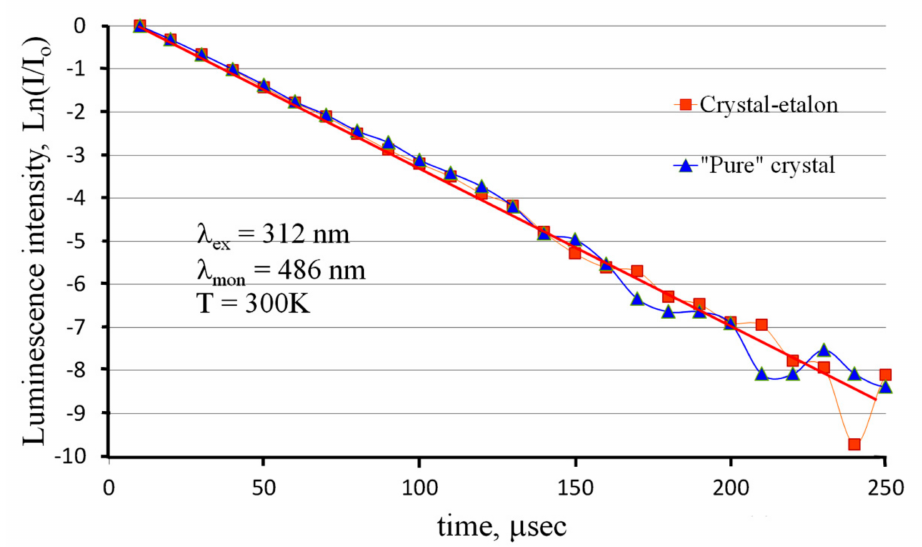
Figure 8. Photoluminescence decay kinetics for the studied ZnWO 4